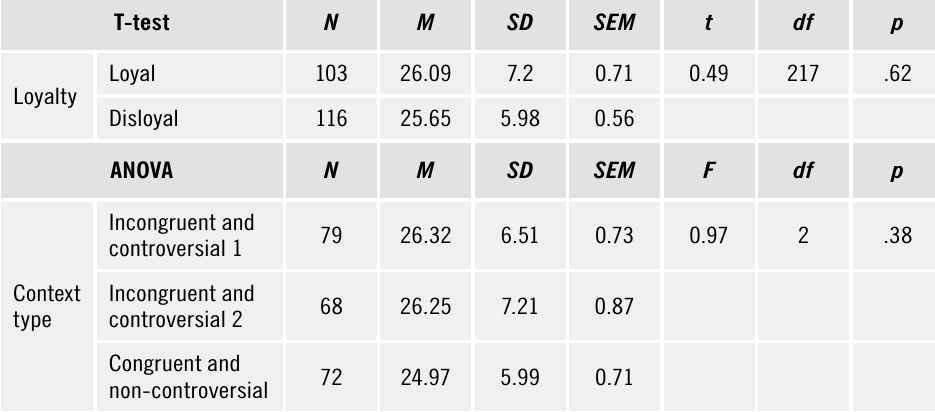
Table 5. Change in age by independent variables